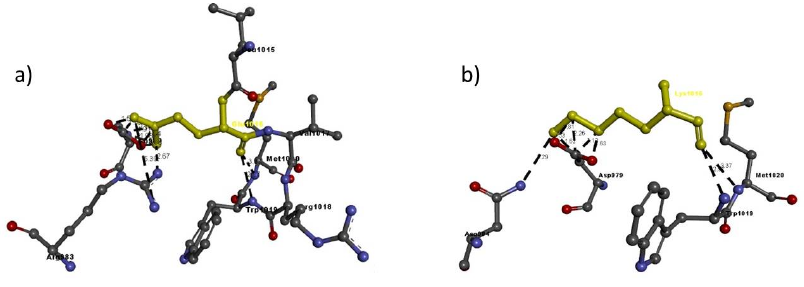
Figure 4. Molecular interactions of ( a ) Glu1016 and ( b ) Lys1016 (in yellow) of the modeled TIE1 protein with adjacent residues.